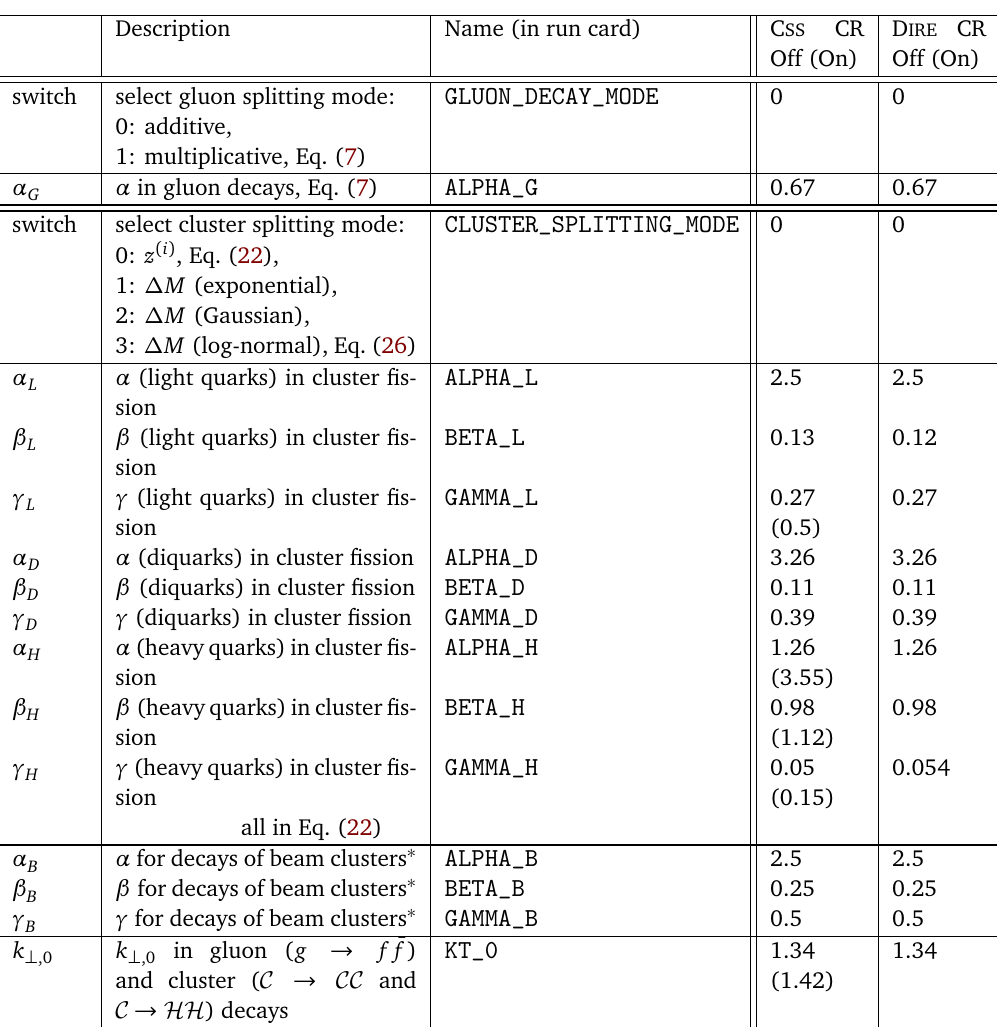
Table 4: Tuned parameters that describe kinematics in the non-perturbative decays of gluons and clusters, Eqs. (6), (7), and (22). ∗ Note that in this publication we do not report on the tuning of the non-perturbative modelling for hadron colliders, which would involve additional physics modelling that we postpone to a future